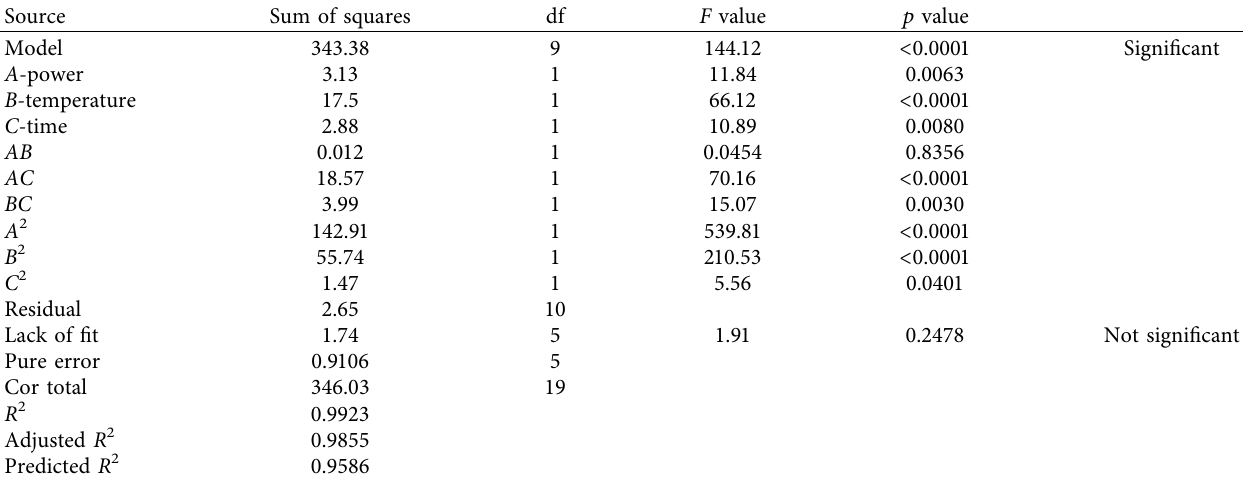
Figure 1: 3D and 2D plots of extraction yield against power and temperature. Table 4: Regression coefcients and ANOVA estimated for total phenol content of MAE moringa leaf